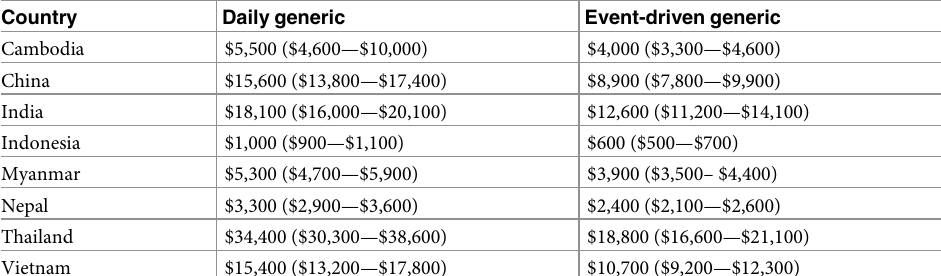
Table 3. Estimated cost per HIV-related DALY averted by 2031 �